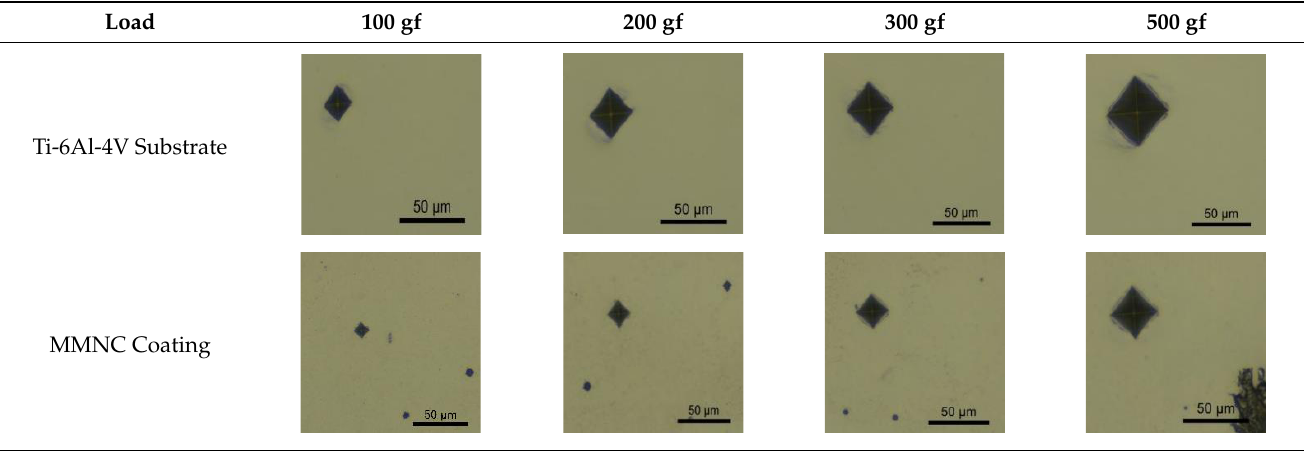
Table 1. Indentation impressions on the Ti-6Al-4V substrate and Ti/SiC MMNC coating.